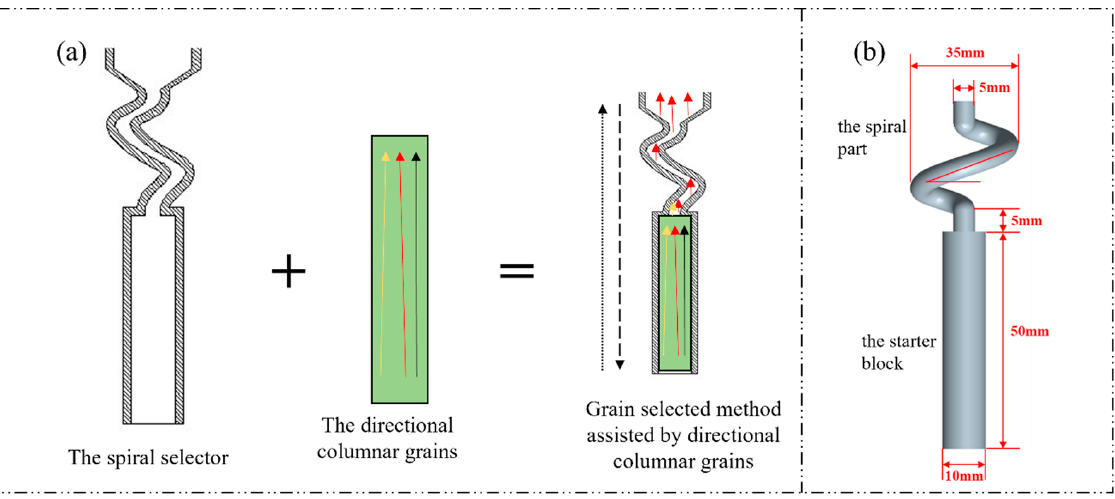
Figure 1. Schematic diagram of the grain selected method assisted by directional columnar grains: ( a ) the novel method; ( b ) the spiral selector used in this paper. Table 1. The nominal compositions of the DZ125 and DD6 (wt.%).